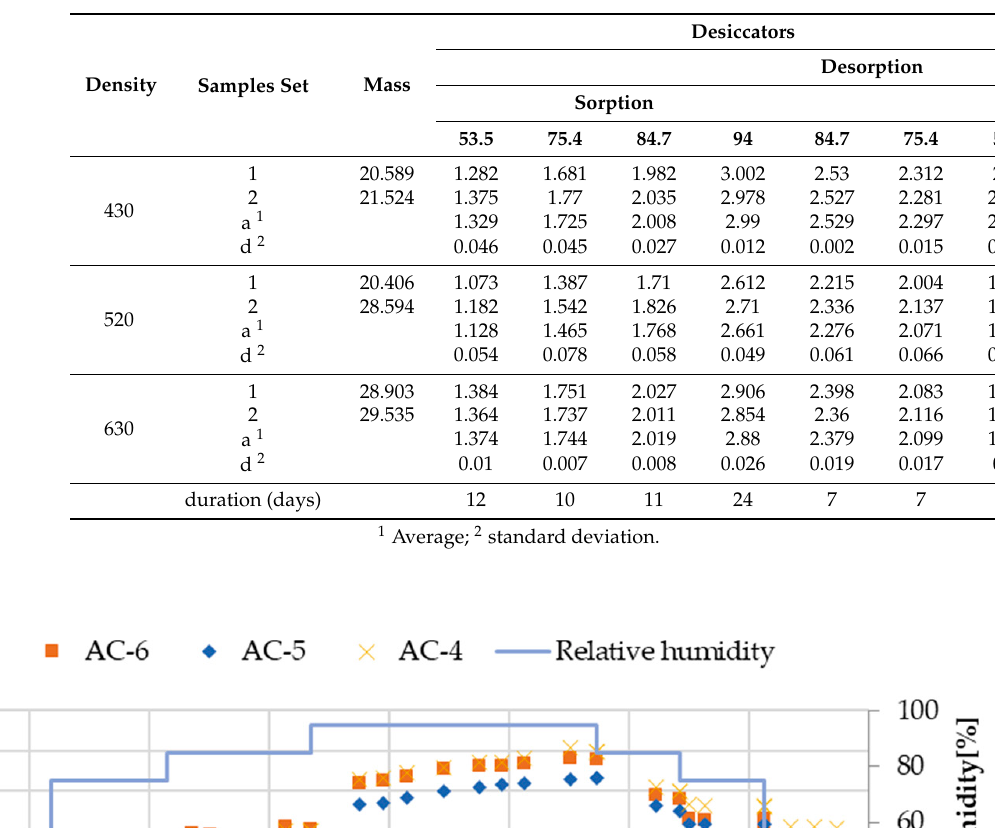
Table 7. Results of the salt solution tests.